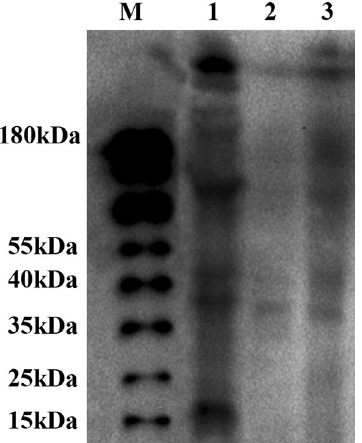
Figure 6. Western blotting results of mycelia and sclerotia for control group and DPI added group. M: marker, 1 and 2 were mycelia and sclerotia in control group respectively, and 3 represents mycelia in DPI added proteins. The raw digital image was uploaded as Supplementary Figure.